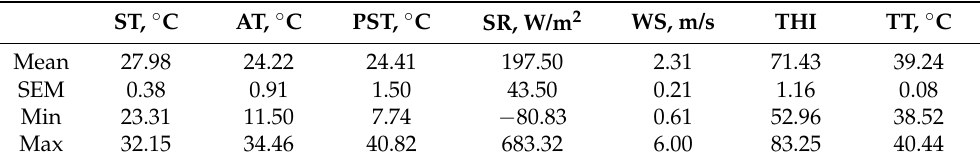
Table 2. Summary of main climatic variables and tympanic temperature for the week of validation (5 to 12 July 2007).